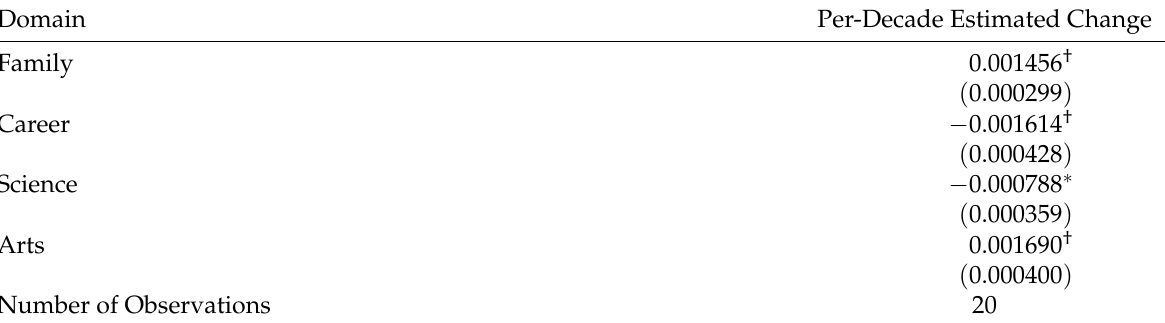
Table 2: Linear regression model of male gender bias over decade by